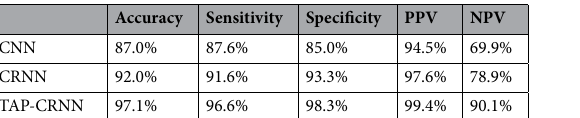
Table 4. Results of testing the algorithm’s ability to distinguish systolic murmurs from normal heart